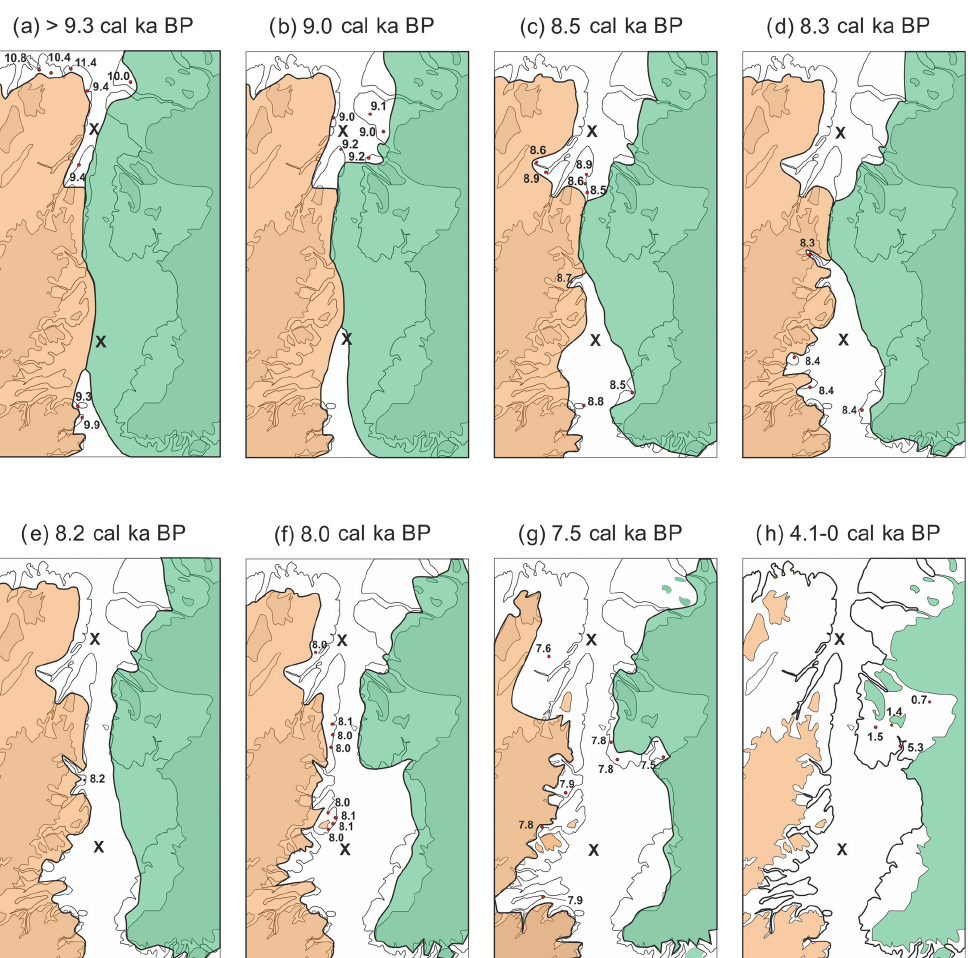
Figure 8. GIS and IIS retreat in Nares Strait. Adapted from England (1999) and including data from Bennike (2002) for Washington Land. Locations for core AMD14-Kane2b in Kane Basin and HLY03-05 (Jennings et al., 2011) in Hall Basin are marked by crosses. All mollusc ages from England (1999) were calibrated with (cid:49)R = 240 using Calib 7.1 (Stuiver et al., 2018) after first adding 410 years to the calibrated ages presented in England (1999) (Table S2 and Fig. S3 in the Supplement). The position of the GIS and IIS margins offshore in Kane Basin are deduced from our sedimentological and geochemical data, while their locations in Hall Basin are deduced from the data presented in Jennings et al. (2011) and Jakobsson et al.